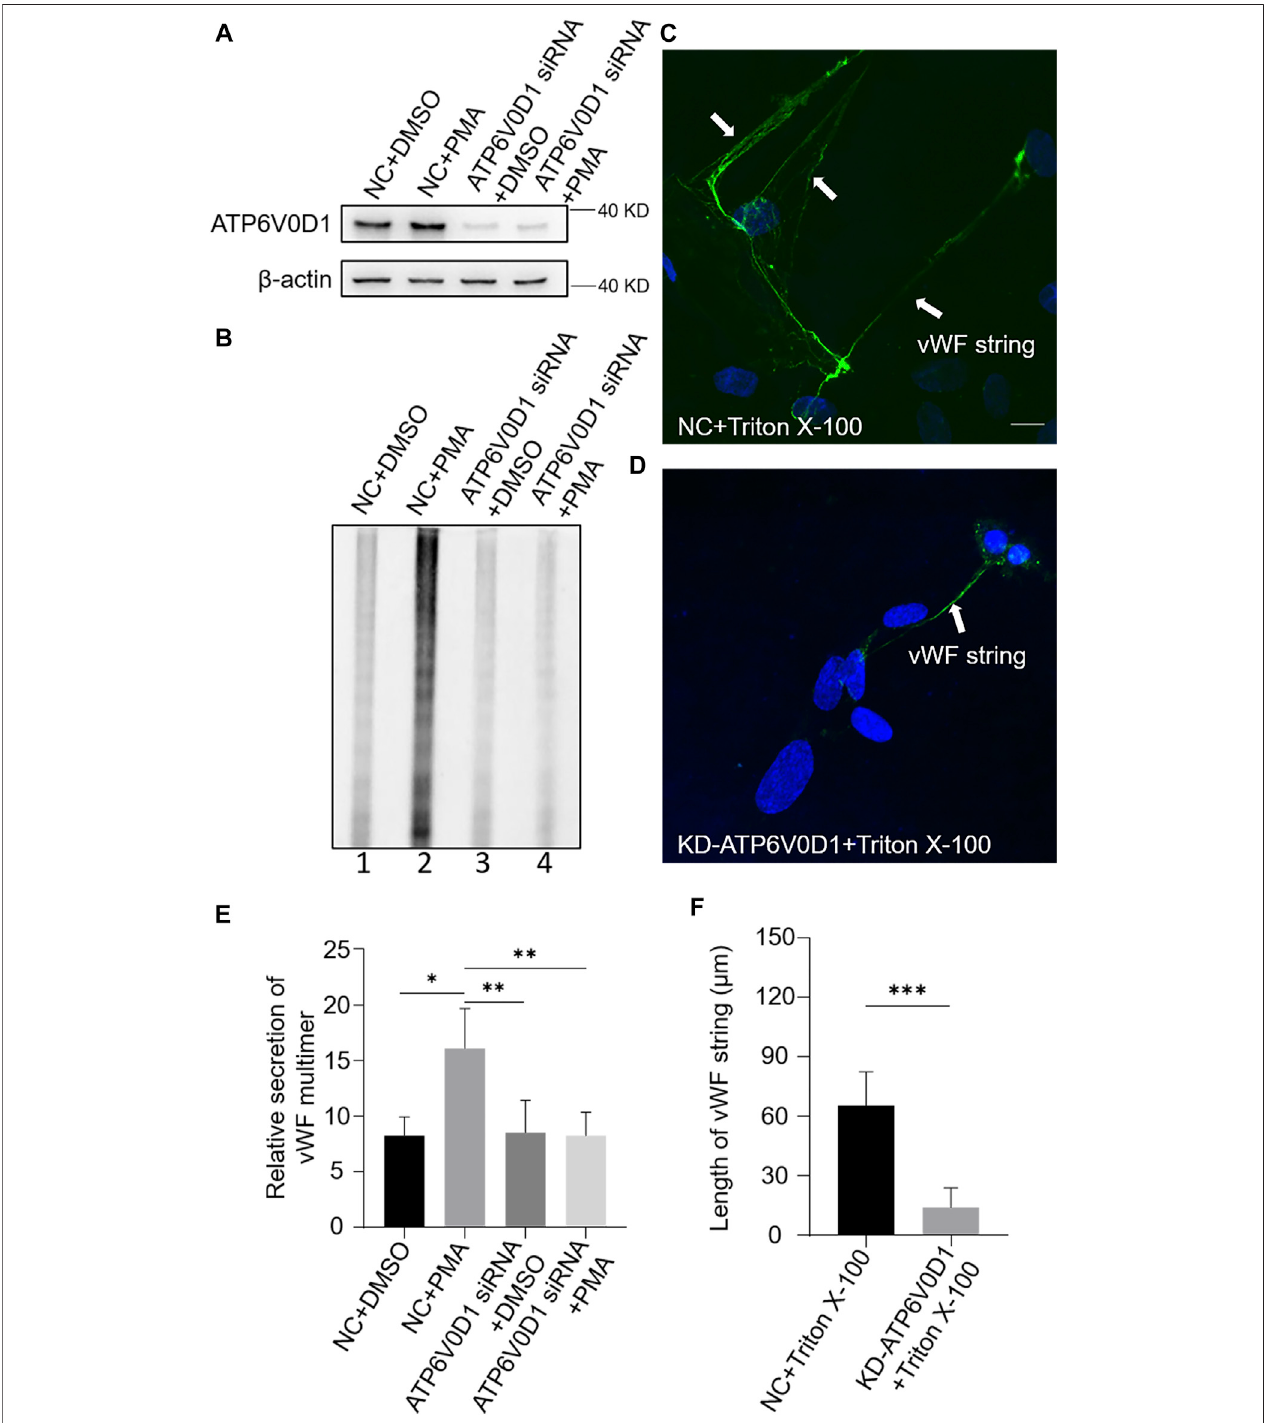
FIGURE 7 | vWF secretion and the ability to generate surface strings are also compromised in KD-ATP6V0D1 human umbilical vein endothelial cells (HUVECs). Negative control (NC) and ATP6V0D1 siRNA were transfected into two groups of HUVECs, respectively. At 72 h later, one group of NC and KD-ATP6V0D1 cells was exposed to 80 nM PMA for 30 min to stimulate Weibel – Palade body secretion, and the other groups were exposed to DMSO (0.1%) instead. ( A ) Western blotting analysis of the detection of ATP6V0D1 knockdown in cell lysate collection. ( B , E ) Western blotting analysis of the detection of vWF multimer secretion in supernatant.MultimergelswereanalyzedusingtheNIHImageJsoftware.Thequanti fi cationofsupernatantvWFmultimerswascarriedoutbasedonthenormalizationof the β -actinproteinlevelofthecellsineachwell. n =5,* p < 0.05,** p < 0.01.( C , D )1%TritonX-100wasaddedintotheculturemediumofNCandKD-ATP6V0D1HUVECs and cultured at 37 ° C for 1 h. Immuno fl uorescence images of two groups of HUVECs labeled against vWF (green) and nucleus (DAPI, blue) were shown. Scale bar, 10 μ m. ( F ) The length of vWF strings at each group of HUVECs was measured by the NIH ImageJ software ( n = 30 per group, *** p < 0.001). Data were expressed as mean ± SEM. Three independent experiments were